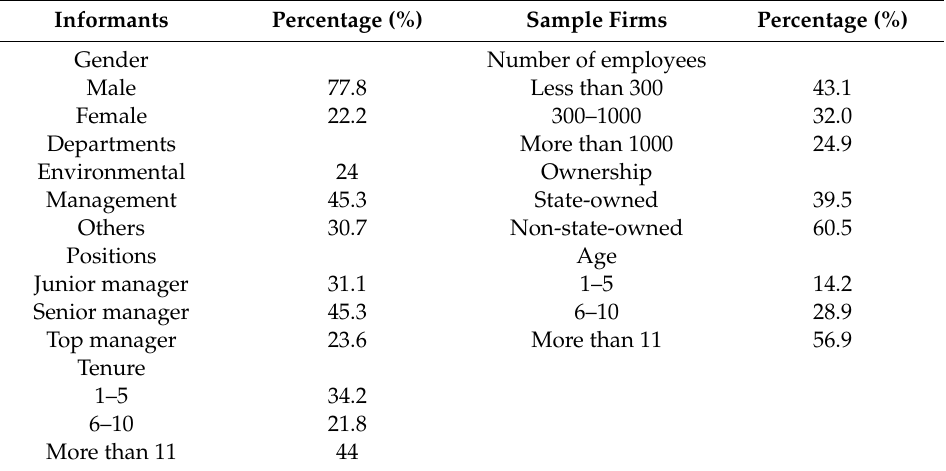
Table 1. Demographic traits of informants and sample